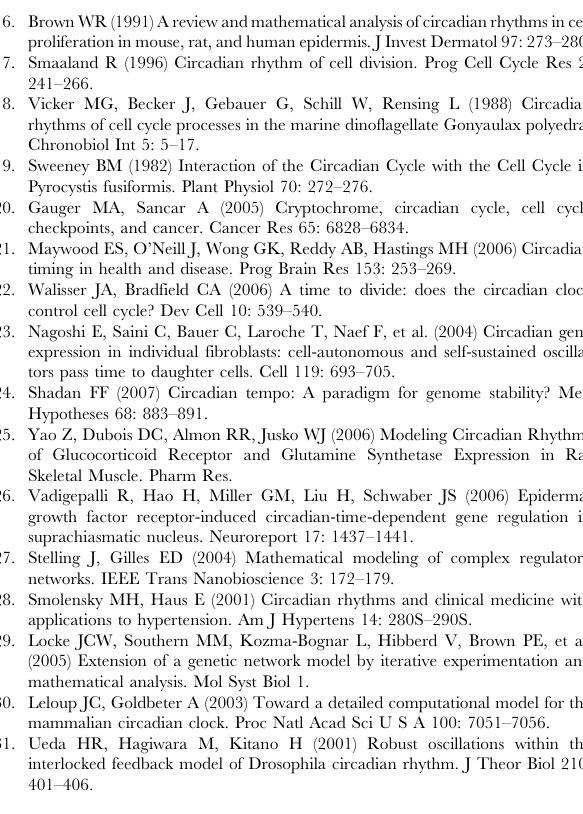
Figure S1 Transcriptional inhibition induced changes under LD cycle conditions in the Goldbeter mammalian circadian model with 19 equations. The LD cycle is first introduced into the circadian model, and the resulting model is simulated. When the model reaches equilibrium, transcriptional inhibition is then introduced into the model. The system changes after inhibition imposition is depicted by the difference in Per mRNA level at light onset between pre- and post-inhibition imposition. ‘‘ + ’’ denotes Per mRNA level at light onset before inhibition imposition; ‘‘.’’ denotes that Per mRNA level at light onset after inhibition perturbation. Figure S2 Transcriptional inhibition induced changes under LD cycle conditions in the Udea Drosophila circadian model. Methods and interpretations are the same as Figure S1. Figure S3 Circadian oscillations are robust to noise. Noises are introduced into the mammalian circadian model as described in